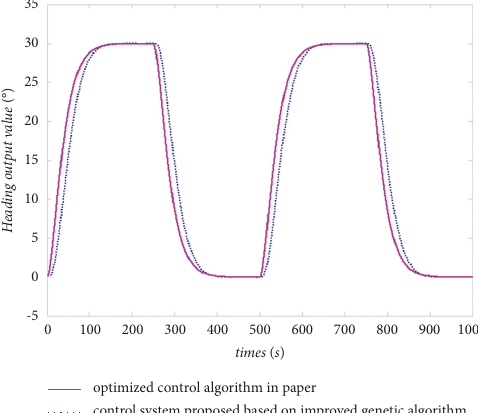
Figure 8: The results of heading output in the comparison